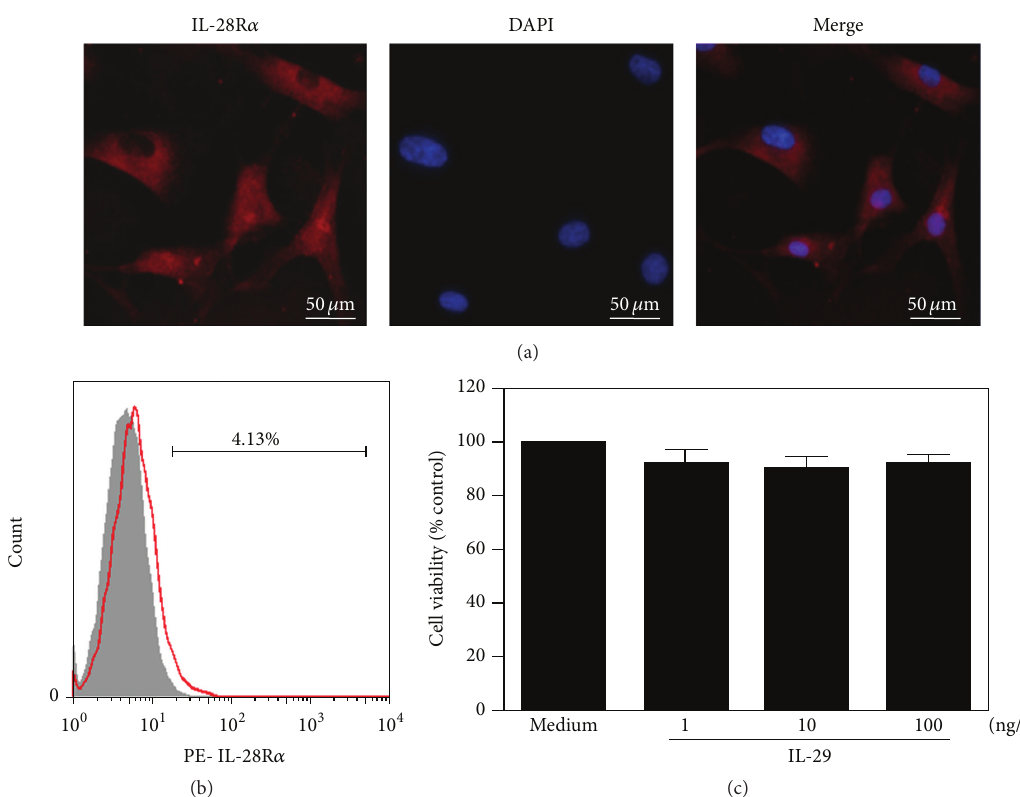
Figure 3: Immunostaining for IL-28R 𝛼 in OA fibroblasts and viability of OA FLS in response to IL-29. The expression of IL-28R 𝛼 in OA FLS, detected by immunofluorescent staining (a) and flow cytometric analysis (b). The magnification in (a) was × 400. (c) OA FLS viability after being incubated with IL-29 at 1, 10, and 100ng/mL for 72 h was measured by MTT assay. The data present the mean ± SEM of three independent